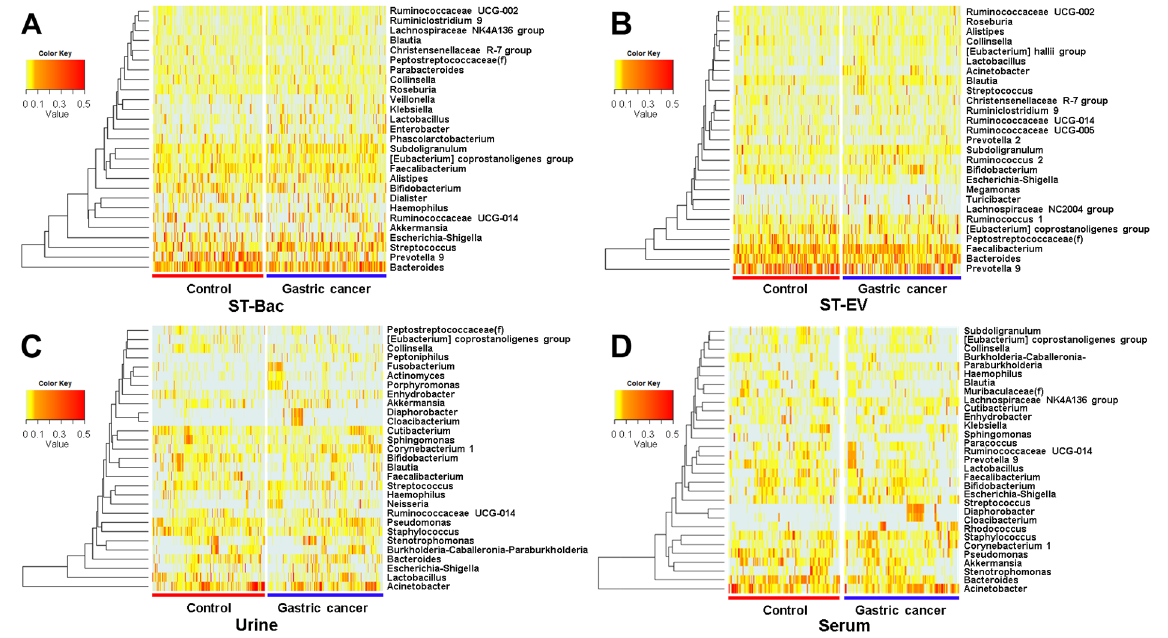
Figure 4. Relative abundance differences in genus level between healthy controls and gastric cancer patients in 4 sample types. Heatmaps representing the relative abundances of microbiome between the two groups ( A ) in stool bacteria (ST-Bac) isolated from stool pellet, ( B ) in stool-derived extracellular vesicle (ST-EV) isolated from stool supernatant, ( C ) in urine, and ( D ) in serum.